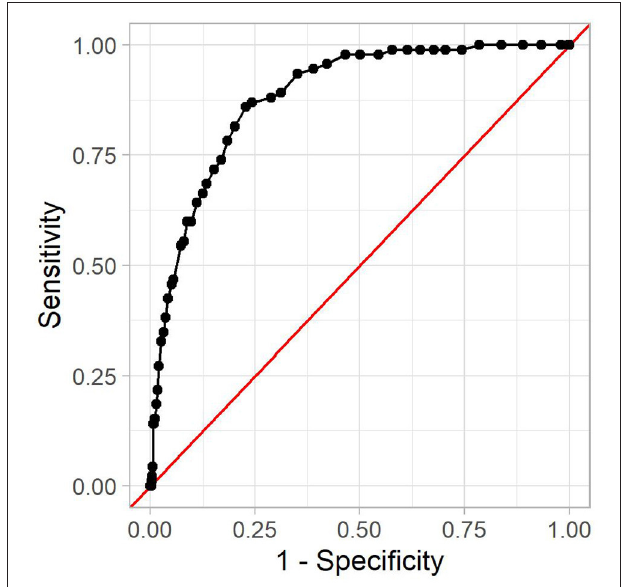
FIGURE 4 | The receiver operating characteristic curve for the reference model. The x-axis shows (one minus) the specificity, and the y-axis shows the sensitivity. Every dot is one possible threshold value. The red line denotes the curve of a random classifier (i.e., a coin